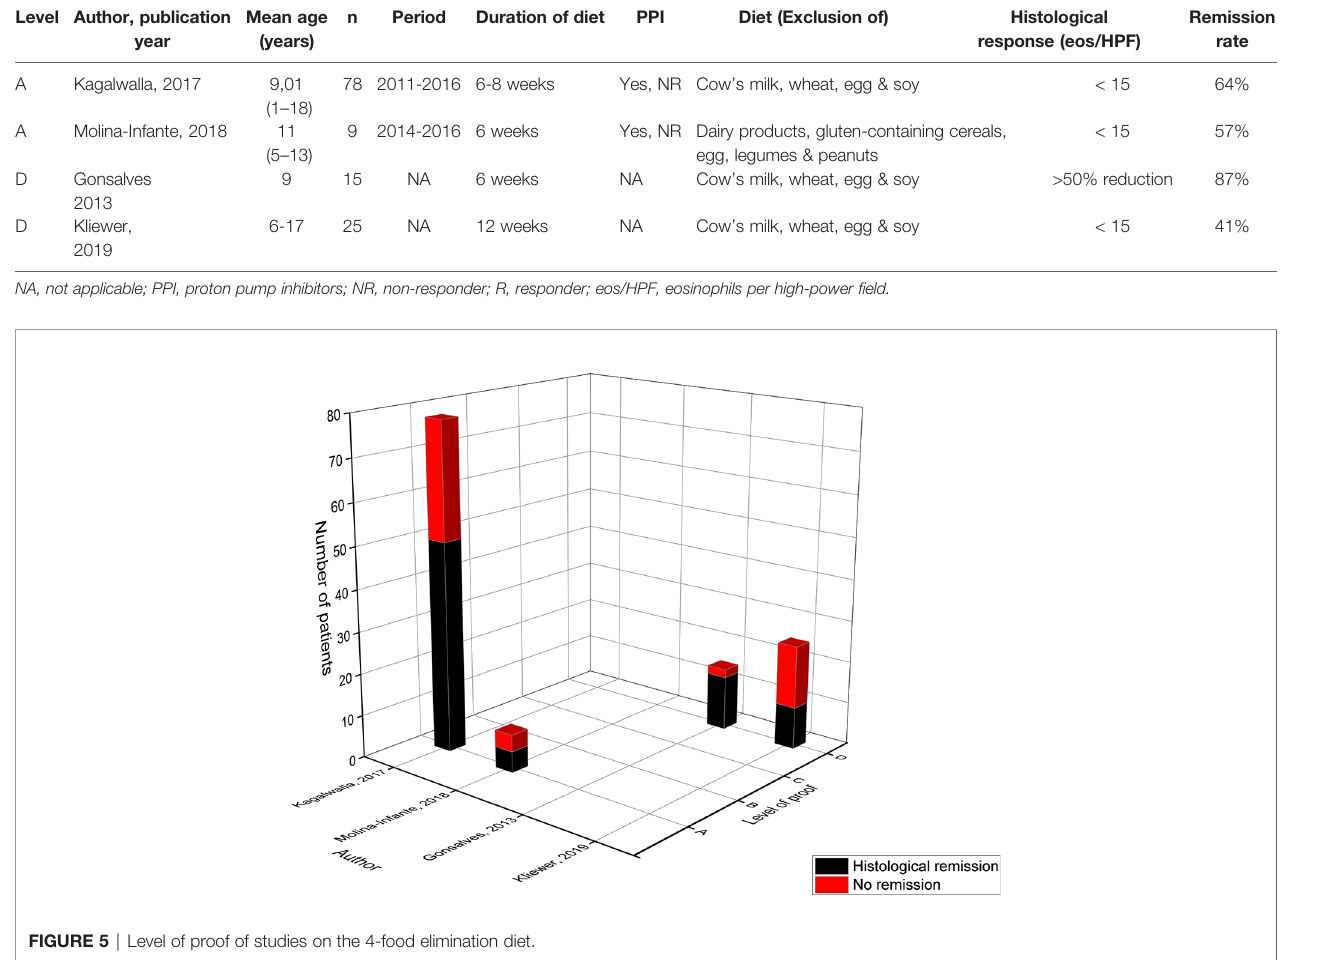
TABLE 5 | Overview of studies on the 4-food elimination diet.